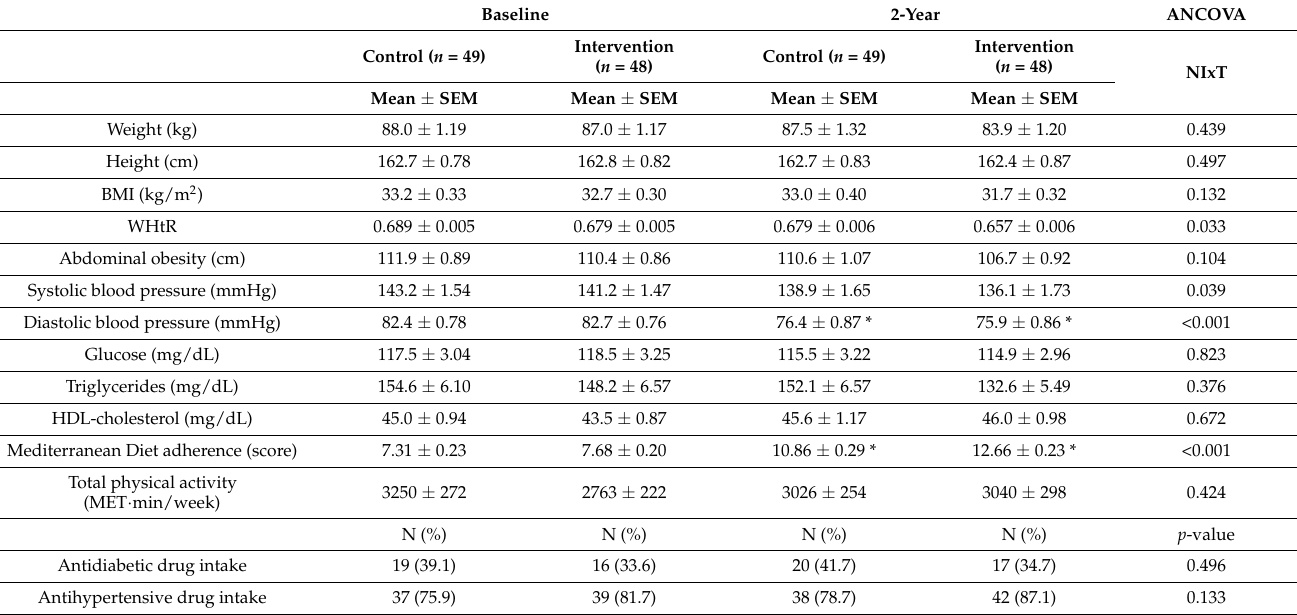
Table 1. Characteristics of participants according to nutritional and lifestyle intervention between baseline and 2-years follow up.